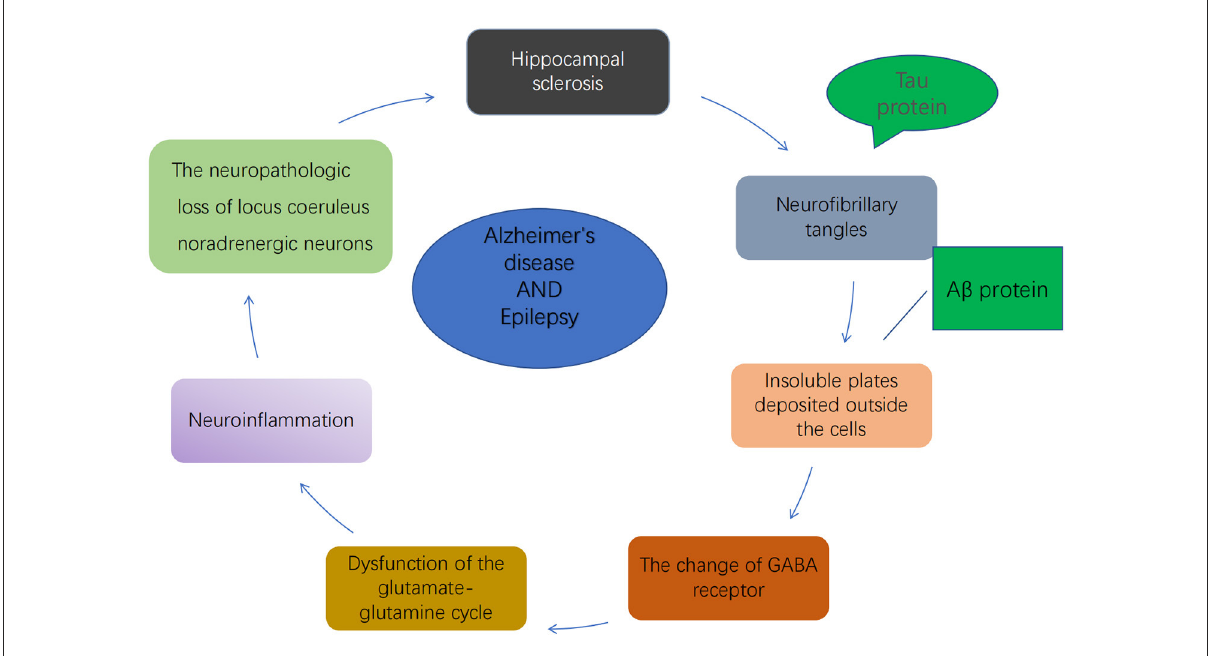
FIGURE1 Possible mechanisms of AD and epilepsy